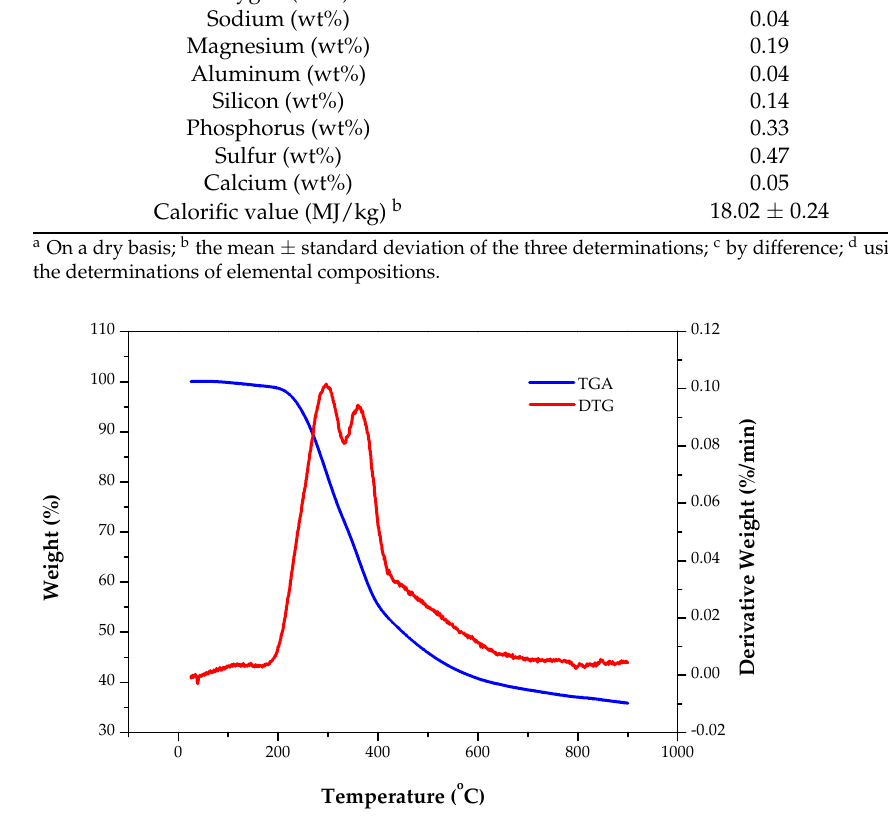
Figure 1. TGA and DTG of pineapple peel (PP) at temperature increases of 10 °C/min under a N 2 gas flow.